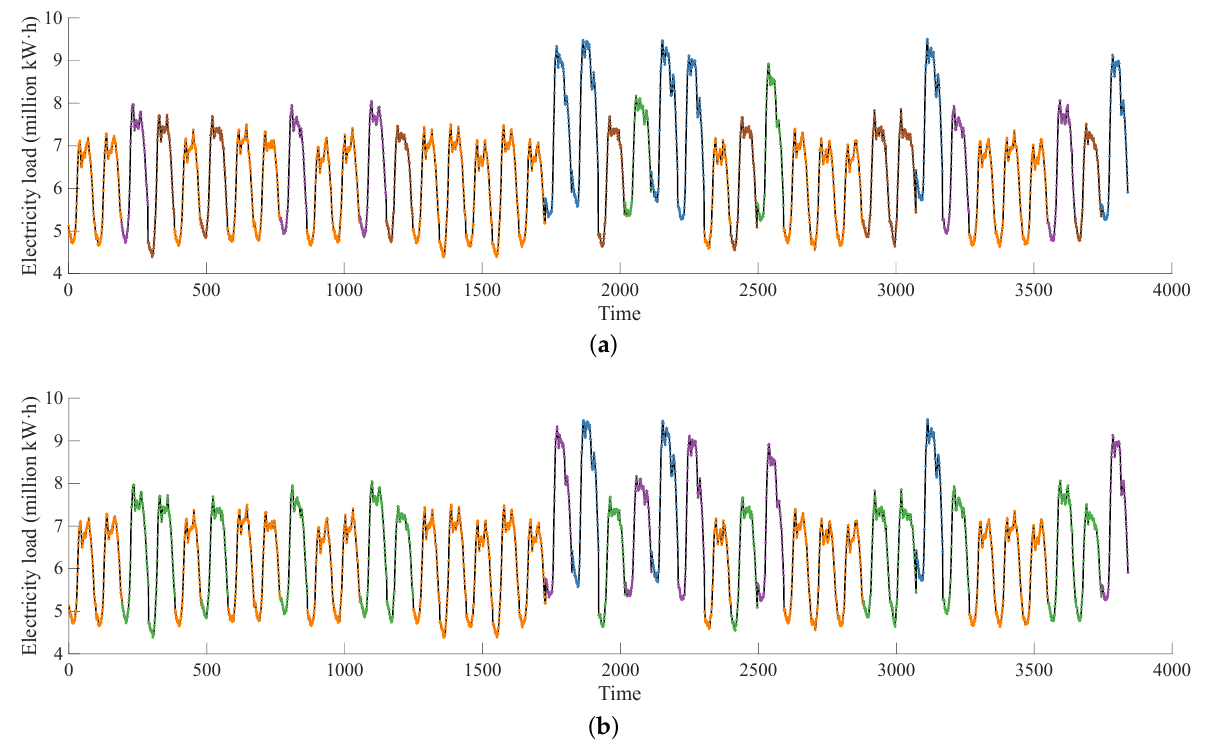
Figure 5. Training time series are divided into different evolving laws based on the learning results of HM-GPFR ( a ) and BHM-GPFR ( b ).